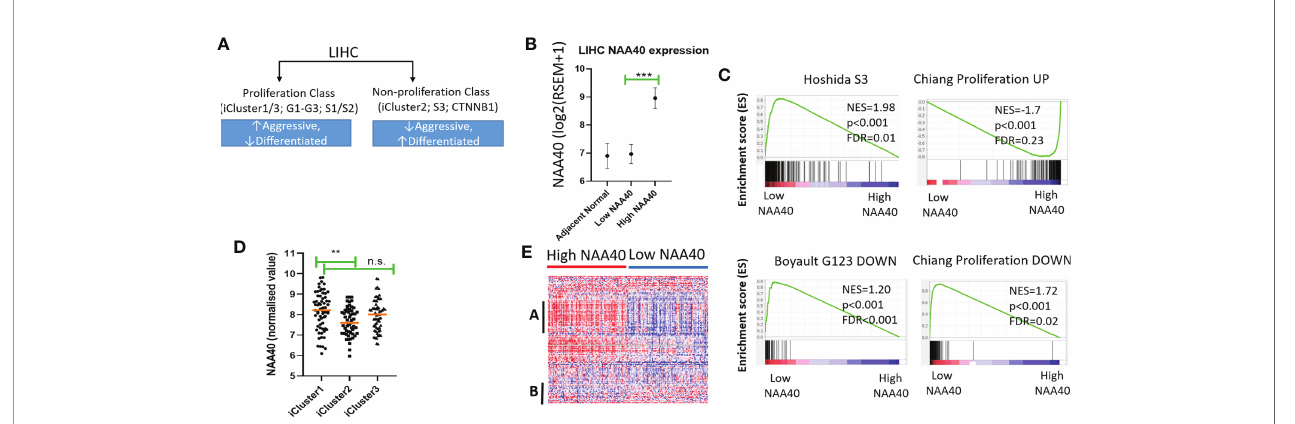
FIGURE 3 | High NAA40 expression in LIHC is a characteristic of more proliferating and aggressive cancer subtypes. (A) Diagram depicting the major molecular subclasses of LIHC adapted from (11); (B) Comparison of NAA40 expression levels in adjacent normal tissue, bottom and top quartiles of TCGA LIHC dataset; (C) GSEA plots displaying enrichment of Hoshida_S3, Boyault_G123_DOWN and Chiang_proliferation_DOWN genesets in low NAA40 expressing samples and Chiang-proliferation_UP in the high expressing NAA40 samples; (D) Heatmap displaying expression of 125 cell cycle-associated genes in High and Low NAA40 samples, with red colour signifying high expression (>value) and blue colour low expression (<value)?. please check if this s/b captured as a panel and appeared as (A, B) indicate two predominant clusters with genes having a direct correlation (A) or inverse relationship (B) to NAA40 expression levels; (E) Expression of NAA40 in TCGA LIHC iClusters. In the scatterplots each circle represents an individual sample and orange line depicts the median value **p < 0.01, ***p < 0.001 Student ’ s t-test. n.s., non signi fi